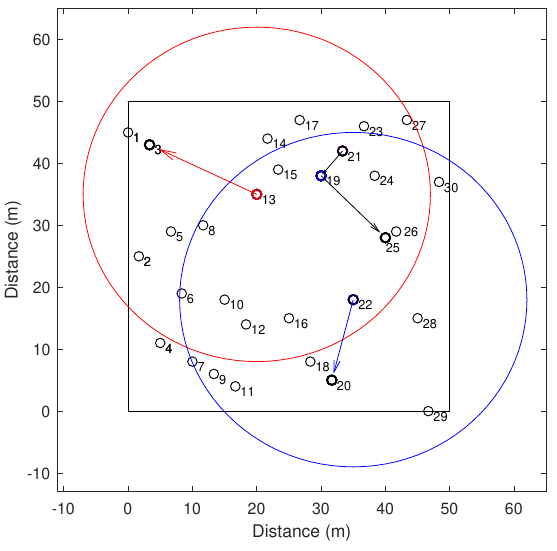
Figure 1. An illustration of node interference